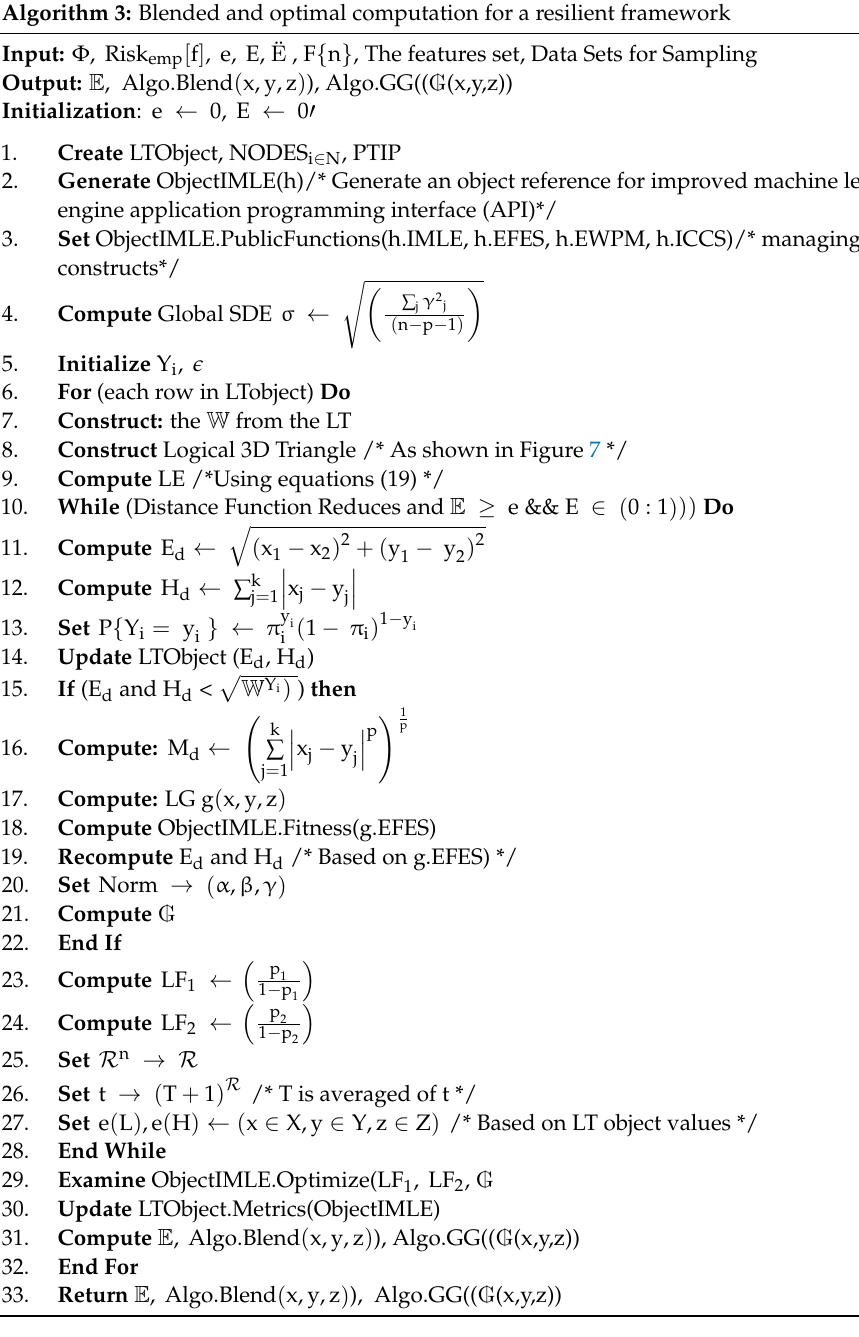
Algorithm 3: Blended and optimal computation for a resilient